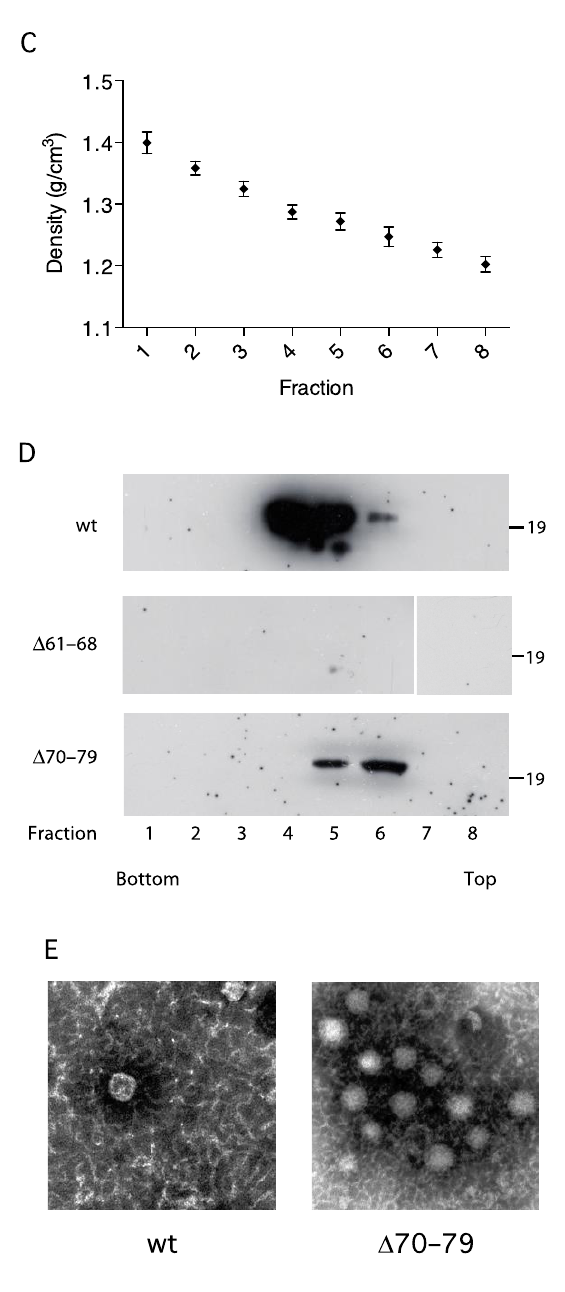
Figure 5. Analysis of nucleocapsid-like particles. HeLa Tet-On cells were transfected with plasmids expressing either full-length (wt) or C deletion mutants ( ∆ 61–68 or ∆ 70–79). ( A ) Sedimentation analysis of wt (1–194) and C mutants. Cellular extracts were loaded on 5–20% sucrose gradients and subjected to ultra-centrifugation. The gradients were fractionated and analyzed for the C protein accumulation as described above. The expected positions of nucleocapsid-like particles (NLPs) are indicated by arrows. ( B ) Map of internal part of D1. Amino acid deletions in ∆ 61–68 and ∆ 70–79 are indicated. ( C ) The densities of C containing fractions were determined by refractometry. ( D ) Buoyant density analysis of wt (1–194) and C mutants. Cellular extracts were mixed with CsCl and subjected to ultracentrifugation. The gradients were fractionated and the C protein was then detected by Western blotting using an anti HCV C antibody. The order of the samples is indicated with numbers from the bottom to the top of the gradient. ( E ) Electron microscopy of the NLPs. Fractions positive for NLPs in sedimentation centrifugation were dialyzed, negatively stained and examined by transmission electron microscopy.